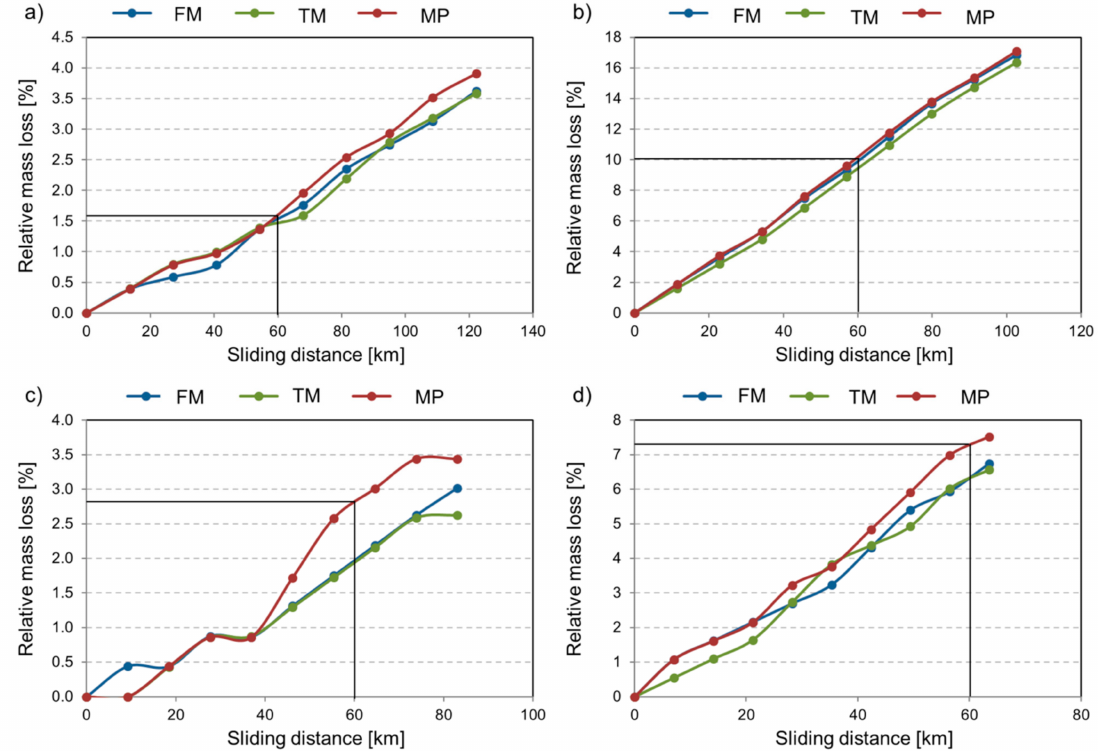
Figure 11. The relative mass loss (%) of the tested materials (FM, TM, MP) in the function of sliding distance in different positions; ( a ) radius 125 mm, ( b ) radius 105 mm, ( c ) radius 85 mm, ( d ) radius 65